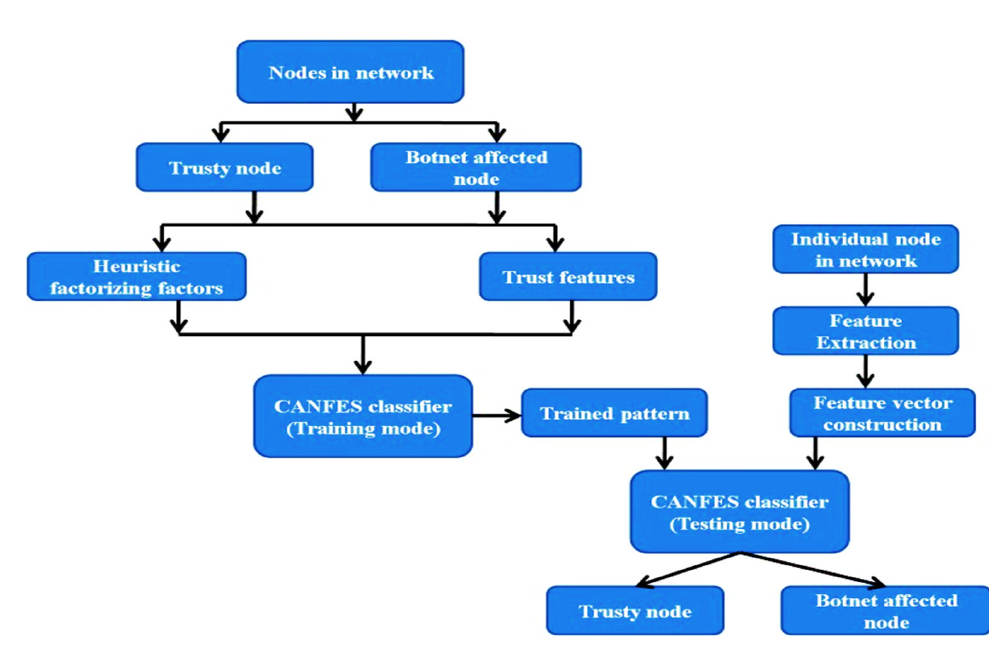
Figure 3. Architectural Diagram of the Proposed Method.